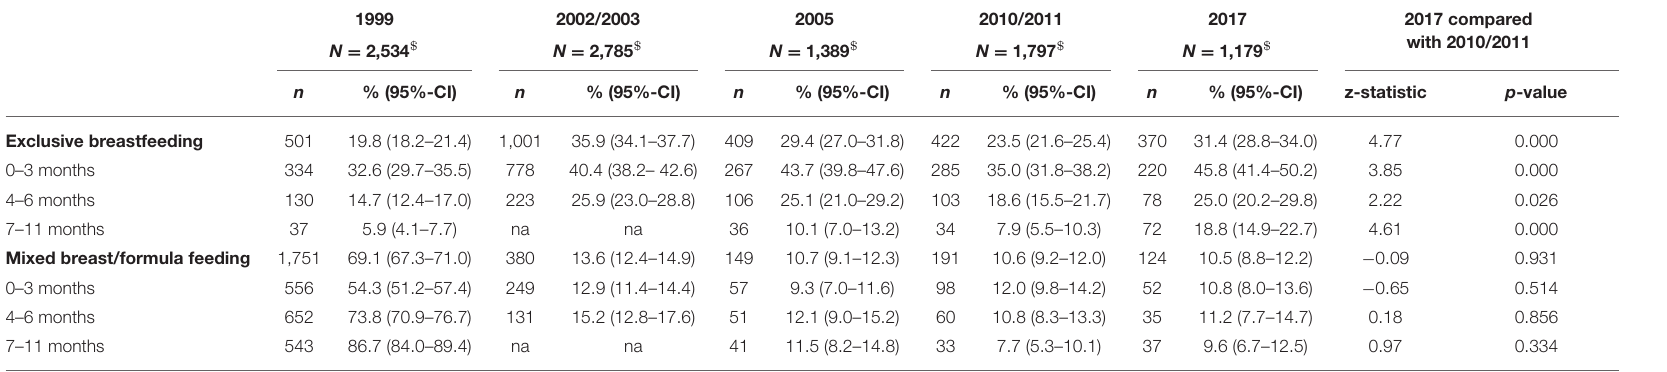
TABLE 7 | Prevalence of feeding type in the five survey populations, including prevalence per age